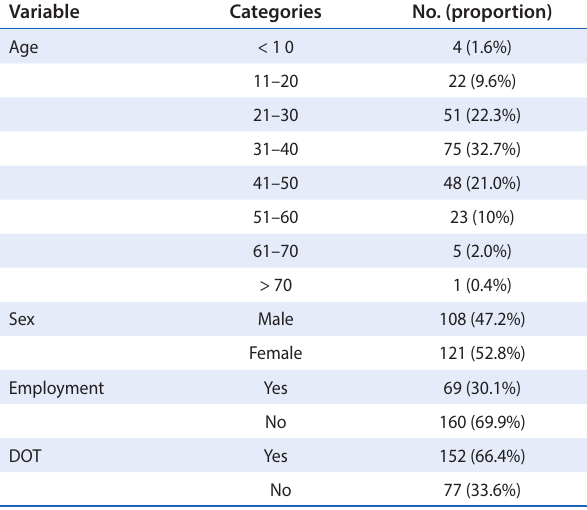
Figure 1: Sampling flow chart.